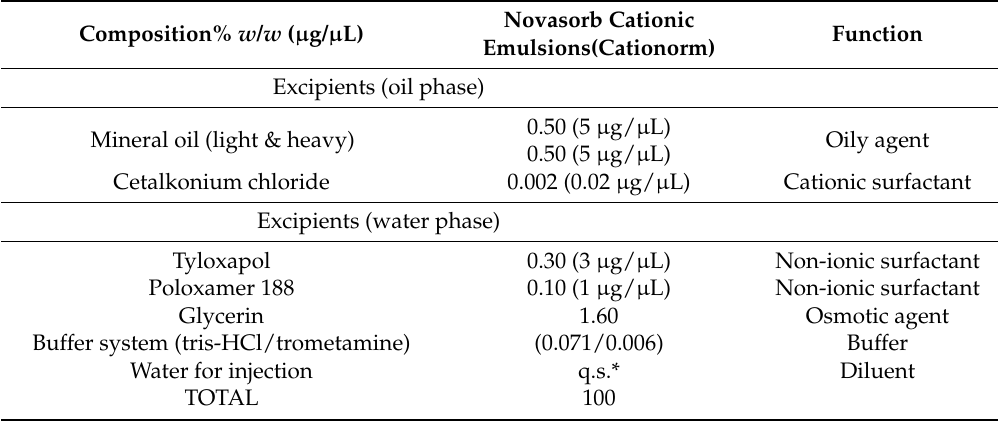
Table 1. Composition of Cationorm cationic